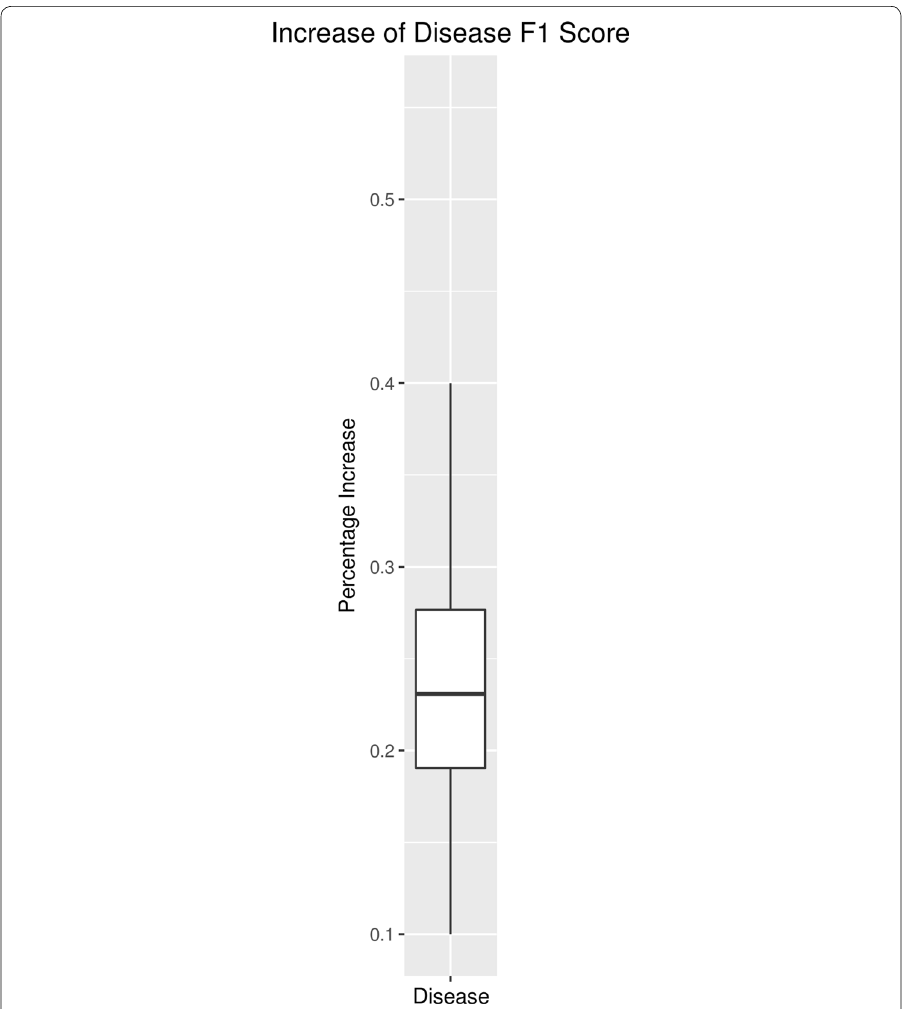
Fig. 8 Box and whisker plot of the percentage increase of F1 scores for baseline vs COED methodologies. Median percentage increase for disease F1 score is